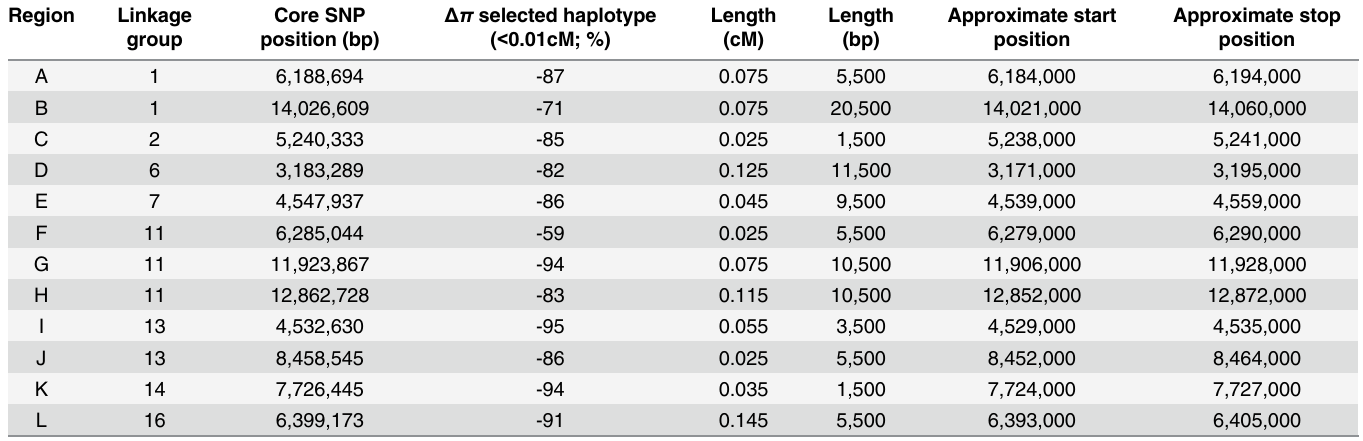
Table 2. Characteristics of sweep regions containing gene